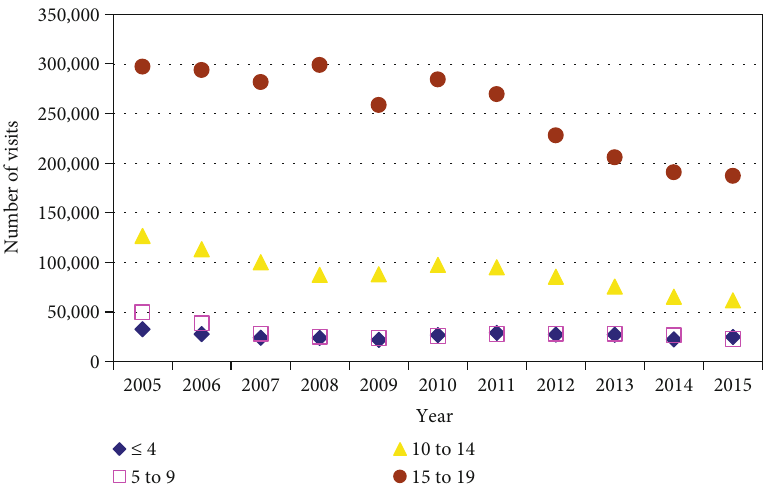
Figure 4: Number of assaults in child and adolescent assault victims over time and by age group. There was a gradual decrease for all age groups except for those ≤ 4 years of age. The number of assaults decreased by 23.7% for those ≤ 4years old ( p = 0 : 28 , r 2 = 0 : 13 ), 54.4% for those 5 to 9 years old ( p = 0 : 026 , r 2 = 0 : 44 ), 51.1% for those 10 to 14 years old ( p < 10 − 6 , r 2 = 0 : 84 ), and 37.0% for those 15 to 19 years old ( p = 0 : 0007 , r 2 = 0 : 84